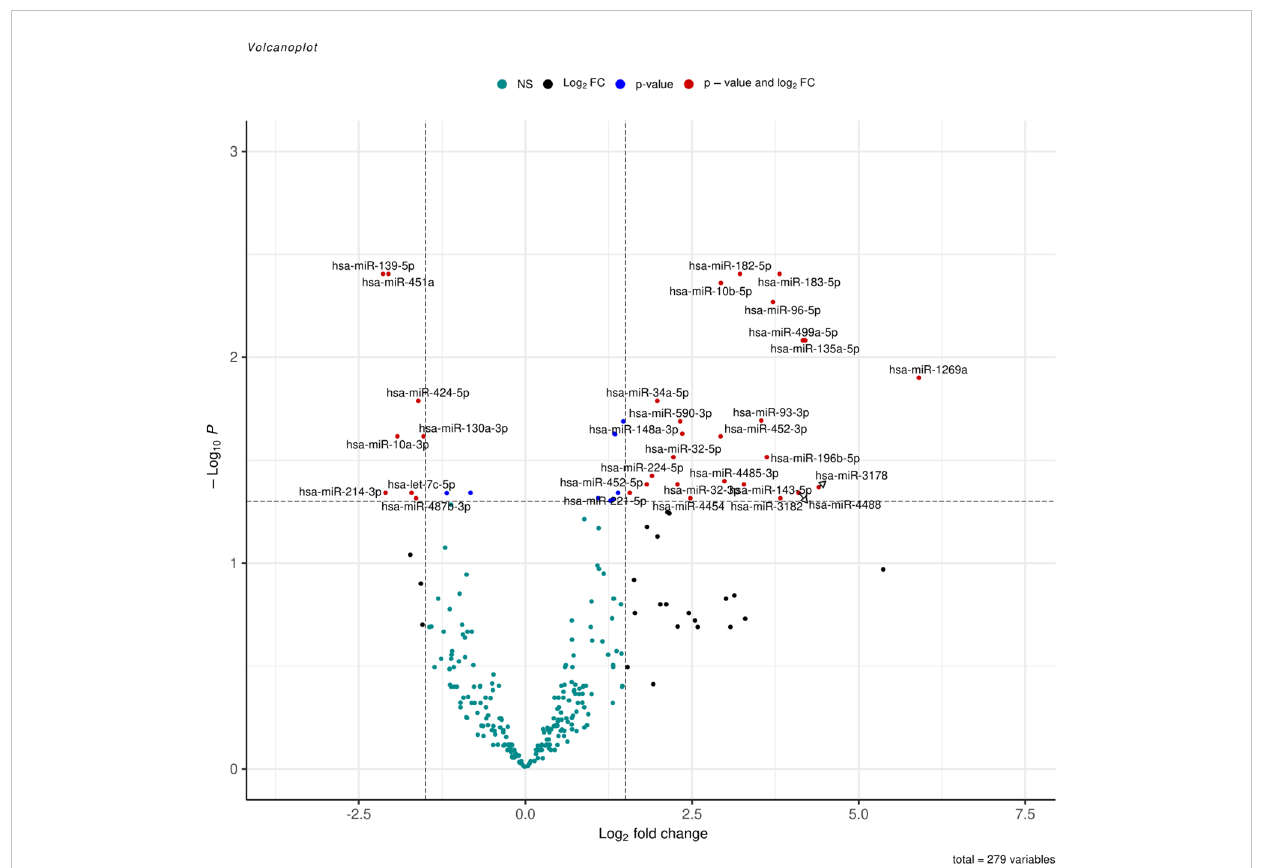
FIGURE 2 Volcano plot represent all expressed miRNA in samples, log2(fold change) is plotted against-log10(p-value), where p-value is from differential miRNA expression test. The vertical dash line represents fold change of >1.5, while the horizontal dash line represents the p-value <0.05. Red dots denote miRNAs that meet both FC >1.5 and p-value <0.05 criteria, while blue dots meet p-value <0.05 but not FC <1.5, and black dots meet FC > 1.5 but not p-value <0.05